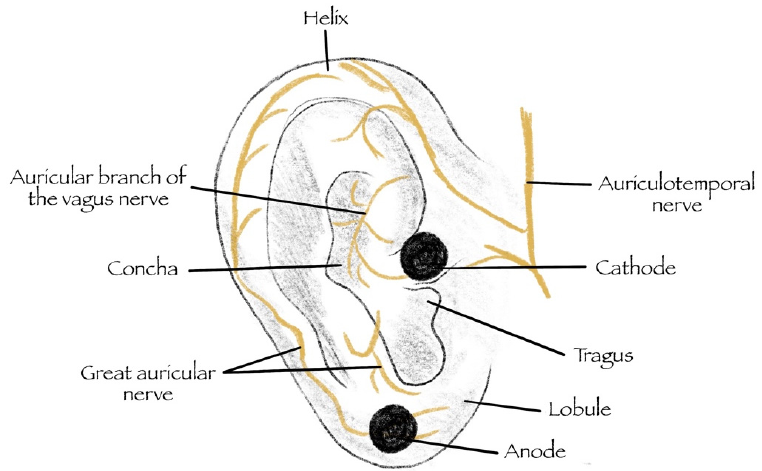
Figure 1. LLTS involves the use of an anode and a cathode to deliver tragus stimulation to the afferent fibers of the vagus nerve (auricular branch). The stimulation charge then enters the medulla oblongata at the brain stem, in turn exciting the efferent fibers of the vagus nerve and enabling the desired cardiac neuromodulation [27].